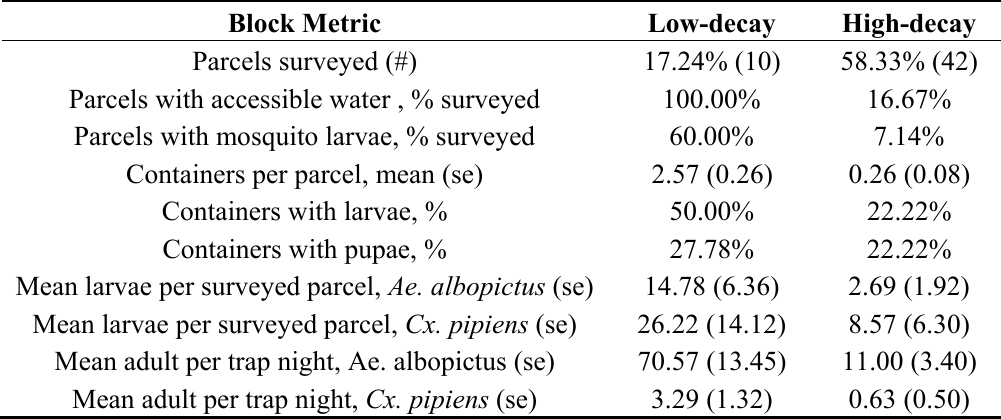
Table 2. Larval sampling